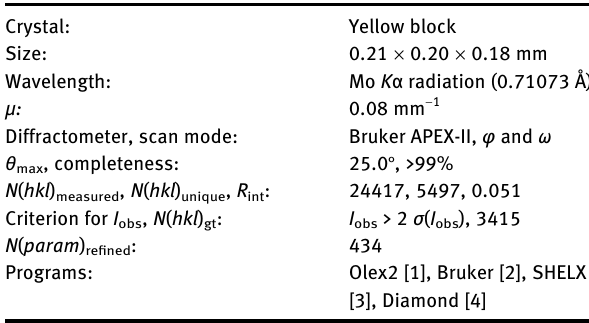
Table  : Data collection and